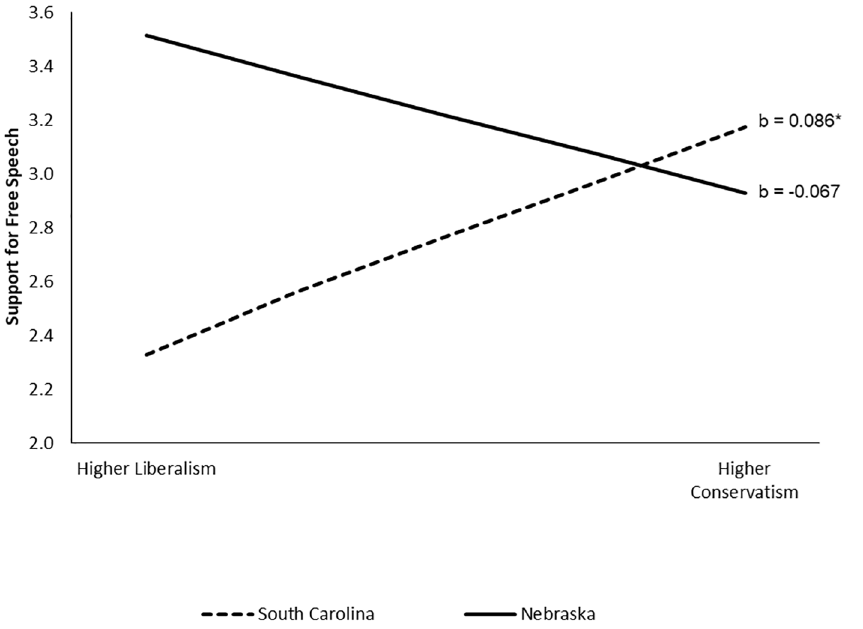
Figure 1. Predicted values for participants’ free speech scale scores based on state collectivism (grand mean-centered) and self-ratings of political orientation (state mean-centered) (Study 1, United States Citizenship, Involvement, Democracy Survey). Note. Estimates for collectivism used values for Nebraska (Collectivism Index = 35) and South Carolina (Collectivism Index = 70) as exemplars of states which lie beyond or close to the region of significance for the interaction. * p <